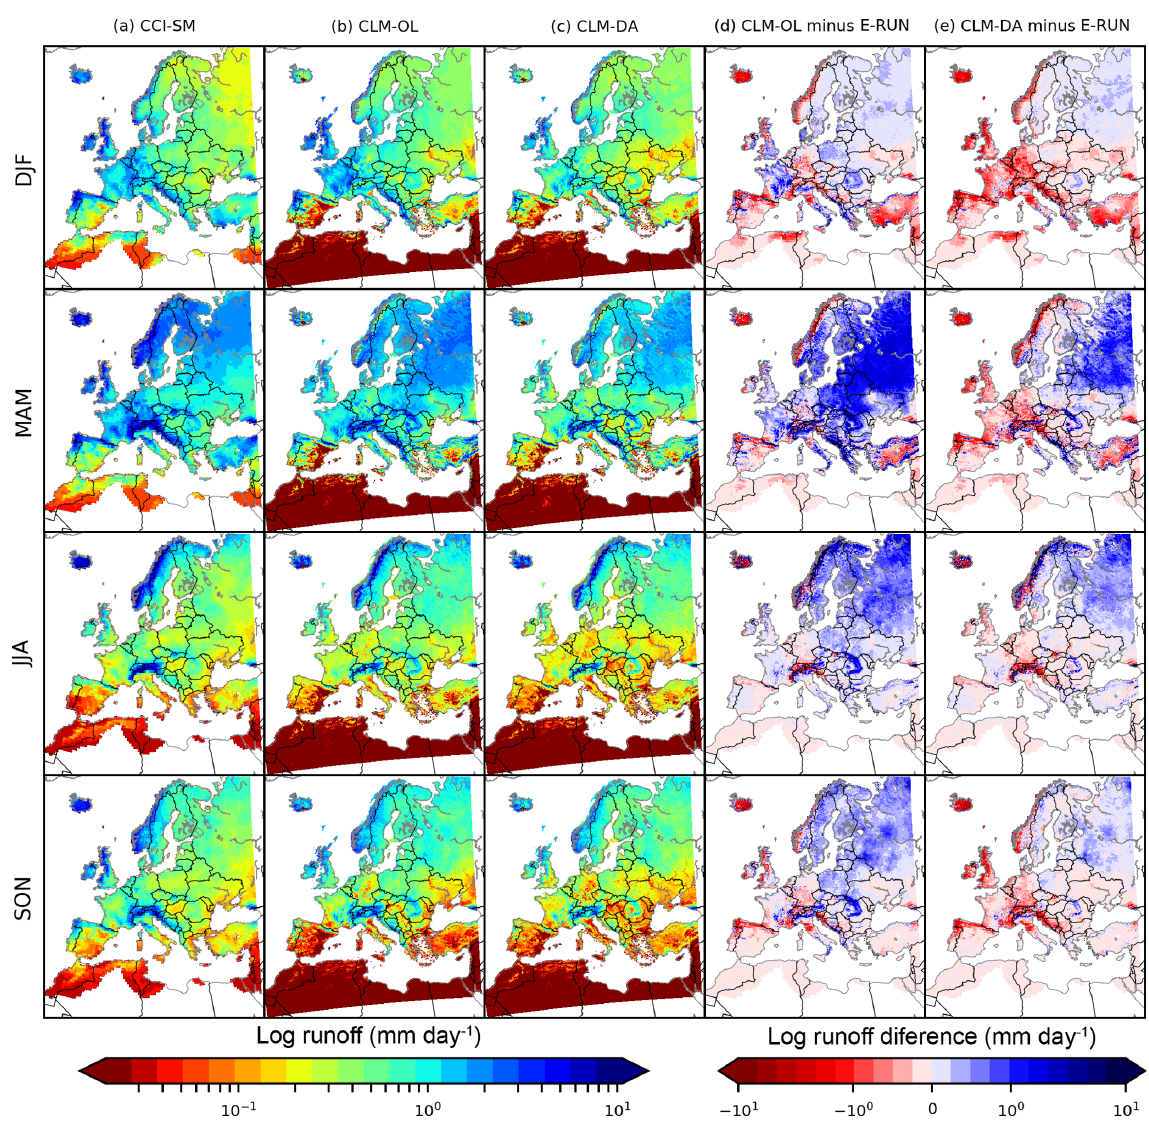
Figure 7. Temporally averaged monthly runoff (mmday − 1 ) at log scale over the 2000–2006 period for (a) E-RUN, (b) CLM-OL and (c) CLM-DA, and the difference between (d) CLM-OL and E-RUN and (e) CLM-DA and E-RUN for DJF, MAM, JJA and SON